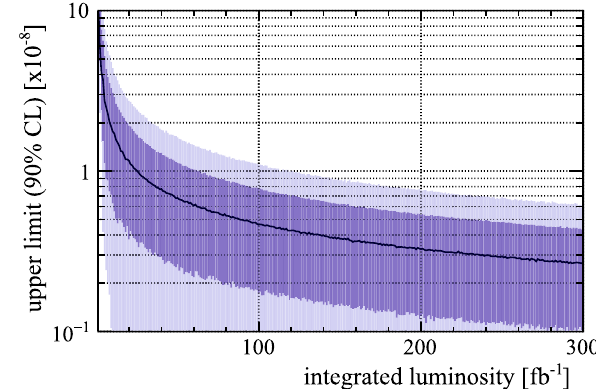
Fig. 3 Expectedupperlimitat90%confidencelevel(CL)on B ( D ∗ 0 → μ + μ − ) obtained using reconstructed B − → μ + μ − π − decays as a function of the integrated luminosity of the LHCb data set. The curve represents the median value from an ensemble of pseudoexperiments and the shaded regions the one and two sigma